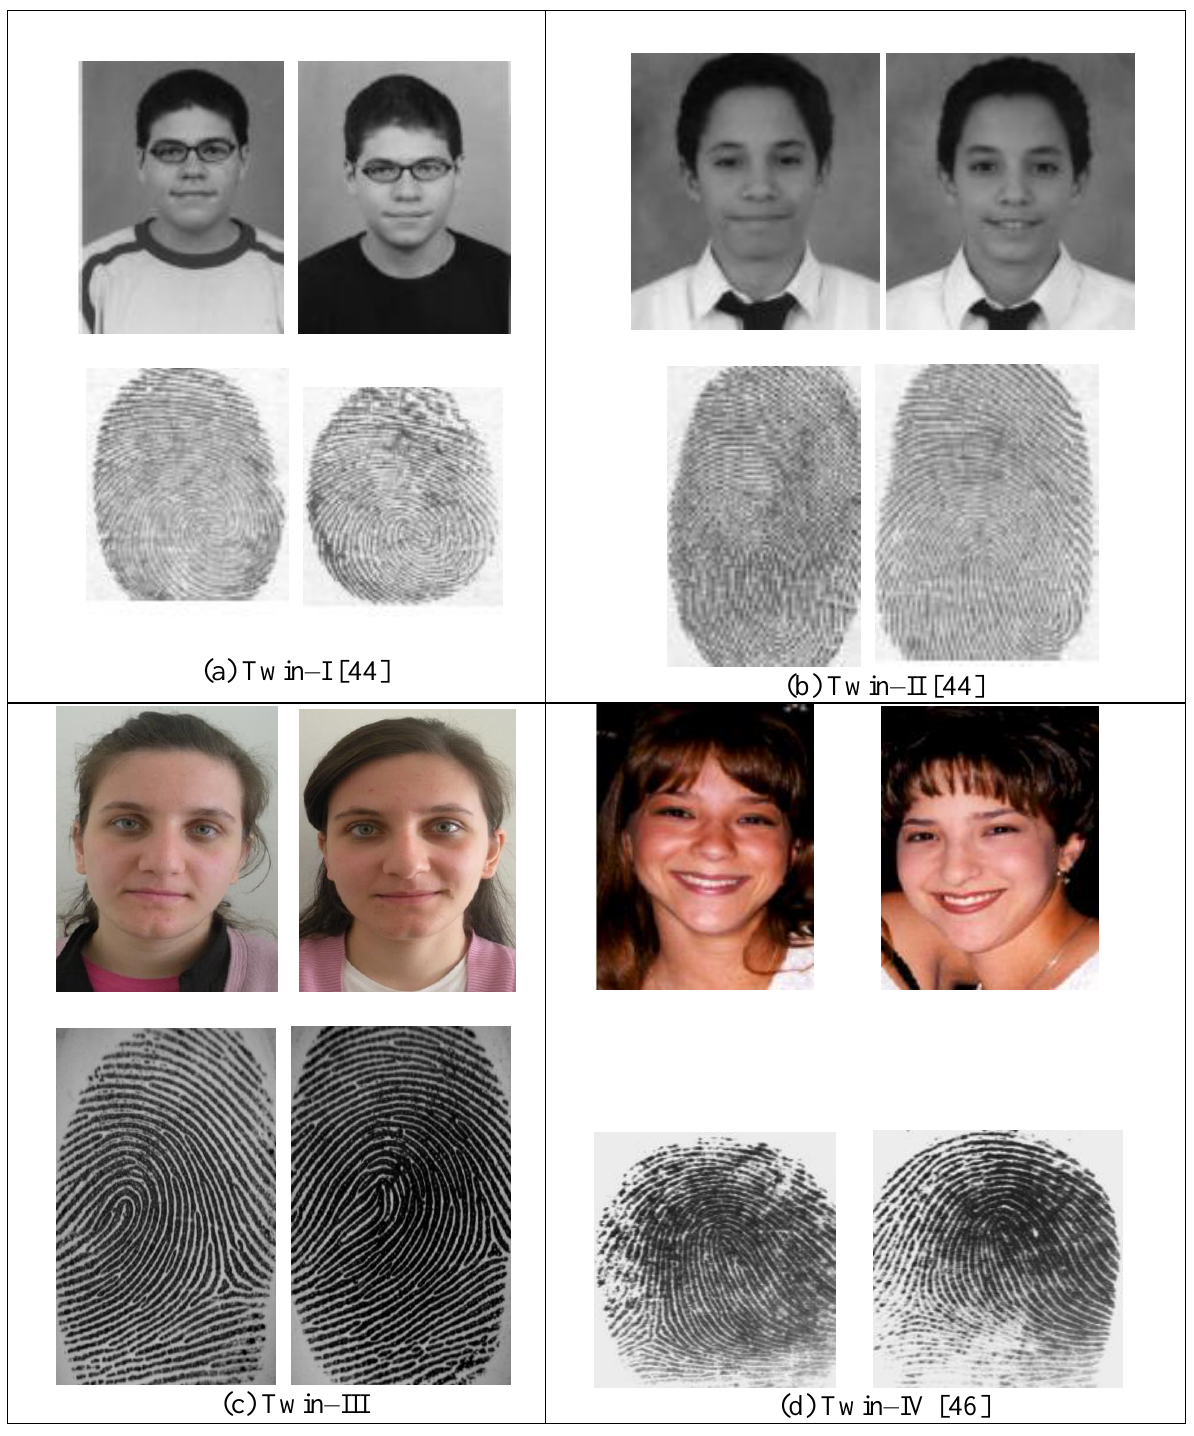
Figure 8. Fingerprints and faces for identical